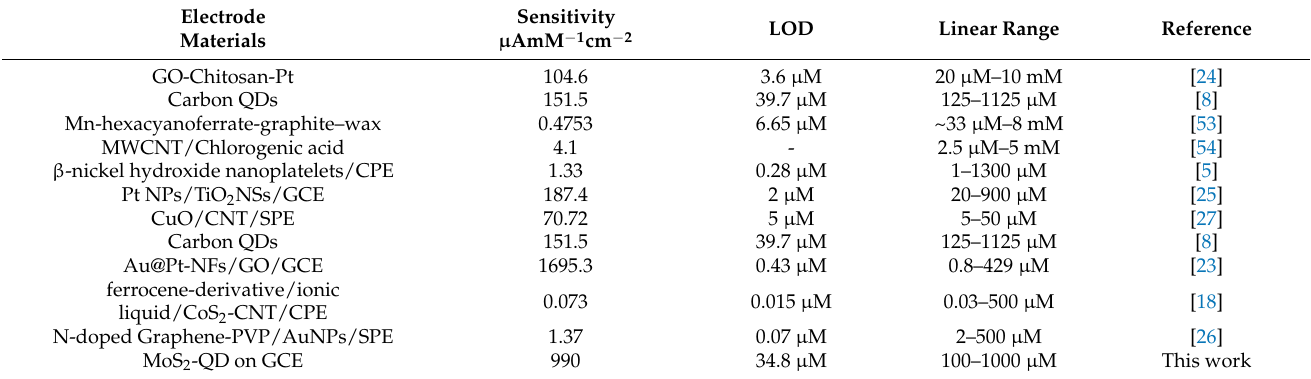
Table 1. Comparison of the performances of MoS 2 -QD-based hydrazine sensors with other reported electrochemical hydrazine